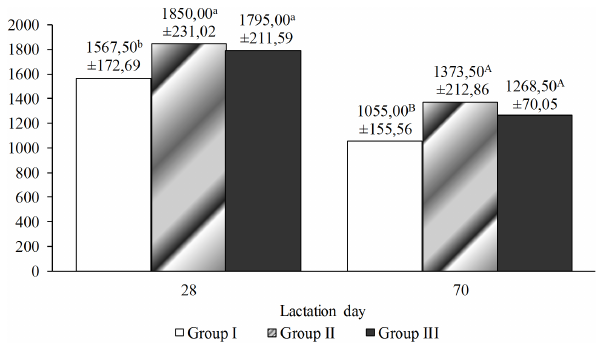
Figure 1. Daily dressing milk (in millilitres). a , b p ≤ 0 . 05; A , B p ≤ 0 .